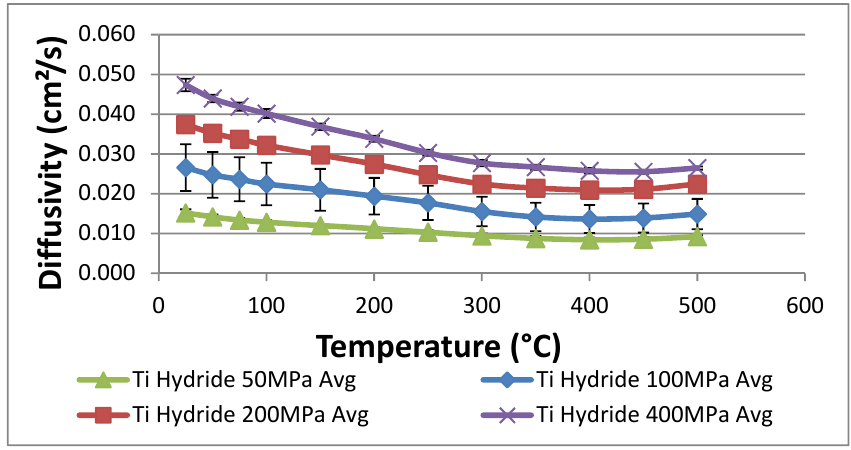
Figure 8. Thermal diffusivity of titanium hydride at various levels of compaction (pressure in MPa), (Avg=